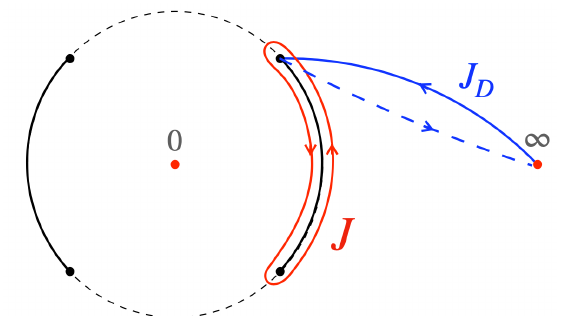
Figure 3 . The period integrals on the spectral curve. The charge of the operator, J , is given by an integral of − p around a branch cut. On the other hand, the logarithm of the two-point function, cl du log h ˜Φ J ˜Φ J i , is given (up to terms that come from regularization) by an integral on a “dual” cycle denoted by J D